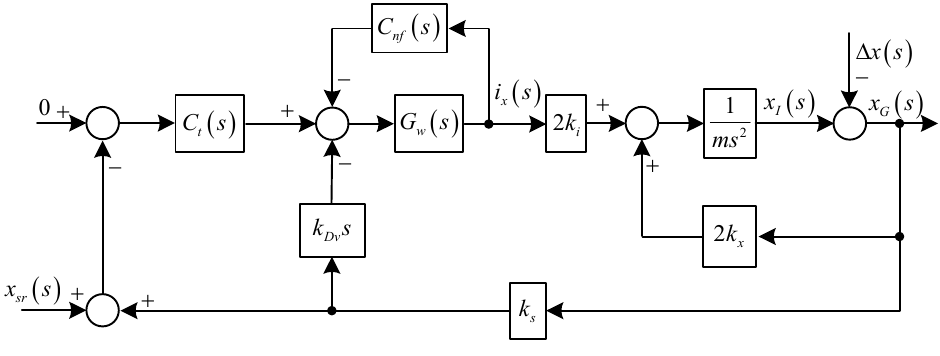
Figure 4. Diagram of the translational subsystem in the X direction with the notch